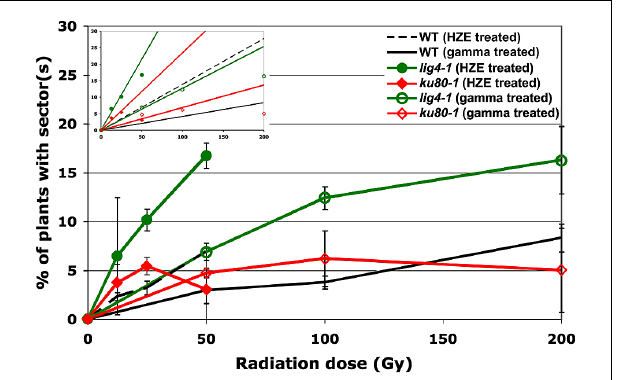
FIGURE 3 | Loss of heterozygosity in repair-deficient plants in response to HZE and gamma radiation. Data points represent the mean of three biological replicates. An average of 216 plants were scored per line, per treatment, per replicate. Error bars depict standard deviation, as calculated by standard statistical methods in Microsoft Excel. Inset: Linear regressions for each dataset. Note: as described in the text, the 50 Gy HZE and 200 Gy Gamma data points were excluded from the regression analysis.